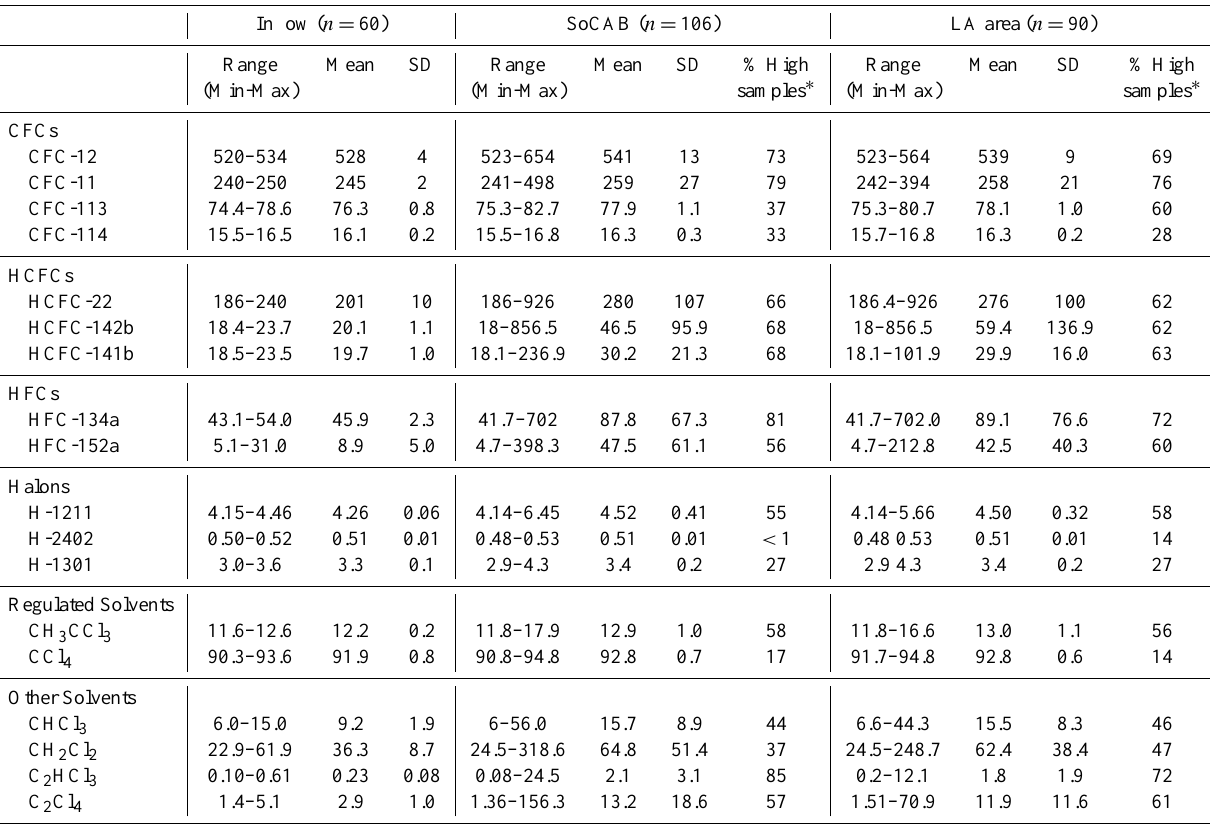
Table 2. Data from air samples obtained in the inflow air mass, over the LA area, and over the SoCAB during the ARCTAS-CARB flights. Data in parts per trillion by volume, unless otherwise specified (indicated as “ppt” throughout the